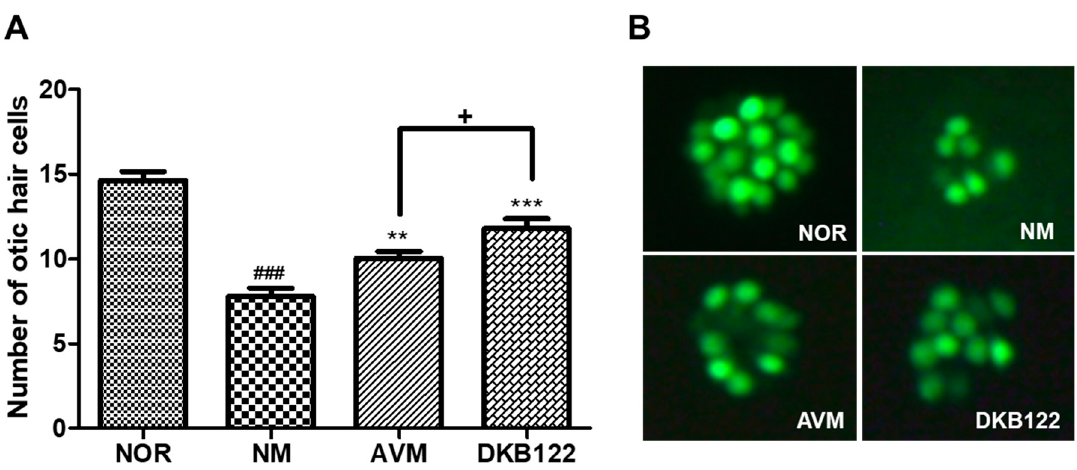
Figure 1. Otic hair cell recovery after neomycin-induced hair cell damage. ( A ) The number of otic hair cells in the untreated group (NM) and the treated groups: 10 µ g/mL crude avocado oil (AVM), 10 µ g/mL avocado oil extract (DKB122). ( B ) Fluorescence images of the zebrafish otic hair cells of the normal (NOR), control (NM), and treated groups. Hair cells stained with 0.1% YO-PRO-1. Data are presented as means ± SEM. + p < 0.05, ** p < 0.01, *** p < 0.001 (control versus treated groups). ### p < 0.001 (normal group versus control group).(